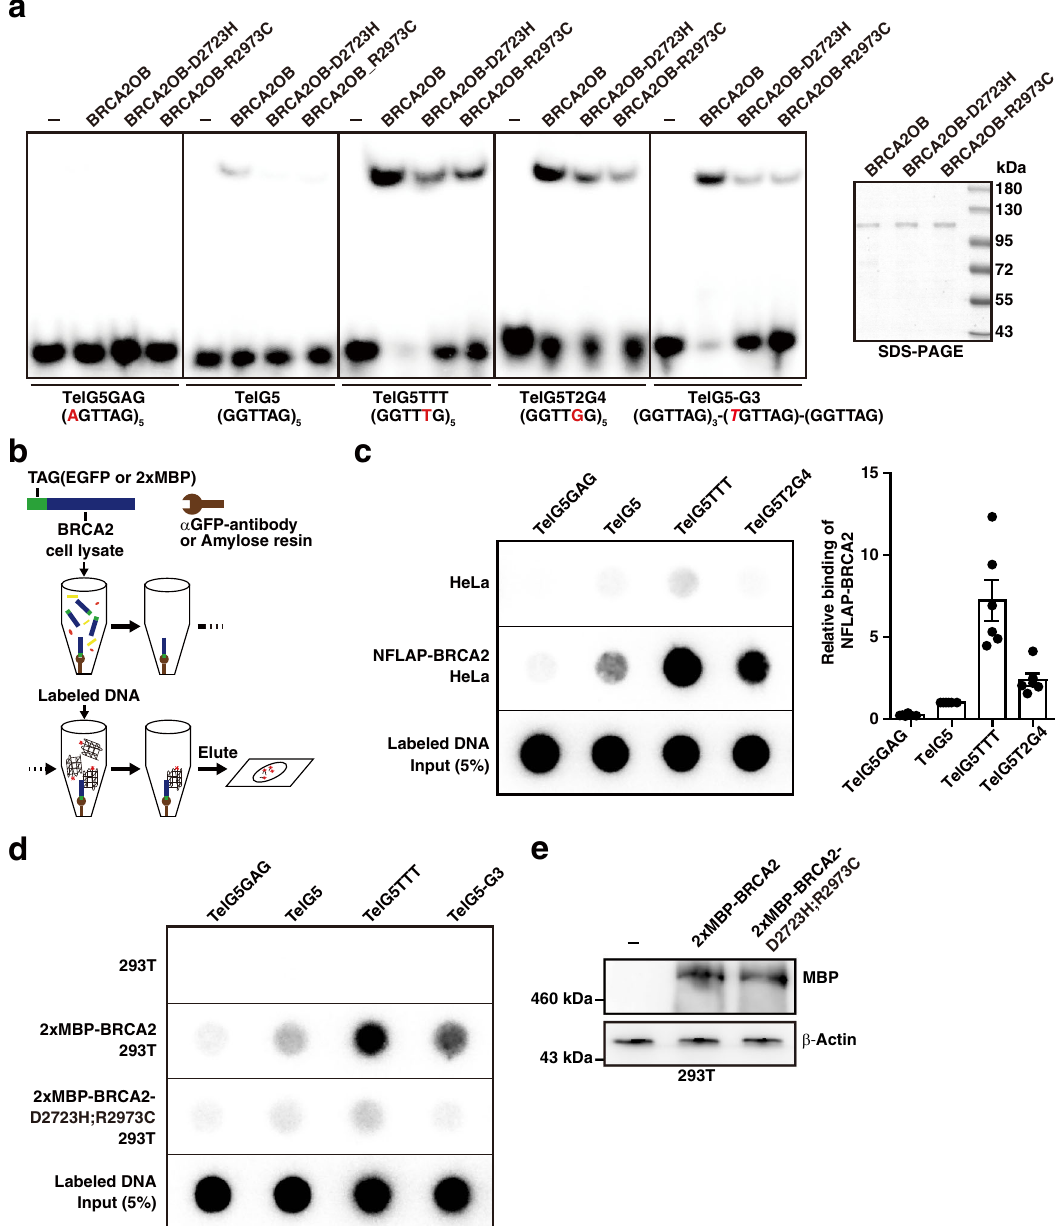
Fig. 6 Pathogenic mutation in the OB-folds of BRCA2 abolishes the BRCA2 binding to telomeric G4. a Recombinant BRCA2OB proteins mutated at D2723H and R2973C, respectively, were subjected to EMSA with telomere probes (left). The SDS-page gel of puri fi ed BRCA2OB, BRCA2OB-D2723H, BRCA2OB-R2973C mutants (right). b – d Binding properties of full-length BRCA2 with indicated telomere variant repeats. b Schematic illustration of the assay. EGFP-tagged full-length BRCA2 was immunoprecipitated from NFLAP-BRCA2 HeLa cells 10,78 and incubated with labeled probes in the presence of 100 mM KCl. Anti-GFP antibody was employed to pull down NFLAP-BRCA2 from the cell lysate. Unbound probes were washed out and NFLAP-BRCA2-bound probes were eluted and subsequently dot blotted. c Dot blots showing the telomere binding properties of full-length BRCA2. HeLa cell lysate served as negative control. Five percent out of the total labeled probes were loaded as controls. Bar graph indicates the relative binding intensity of full-length BRCA2 to DNA probes (mean ± s.e.m.). The result is from six independent experiments. d The effect of OB-folds mutation in binding to telomere G4. Full-length wild-type and mutant BRCA2 -expression constructs, tagged with 2X MBP (Maltose binding Protein), were transfected into 293 T cells. Forty-eight hours later, 293 T cell lysates were subjected to BRCA2 pull-down using amylose resin, then subjected to binding to various telomere G4 variants, including TelG5-G3, and washed. Bound probes were dot blotted as in b and c . Five percent of the probes were blotted for control. The result is the representative of three independent experiments. e Western blot analysis of wild-type and mutant BRCA2, performed simultaneously with d after transfection into 293 T cells to assess the expression level of wild-type vs mutant BRCA2 level. The result was repeated in two independent